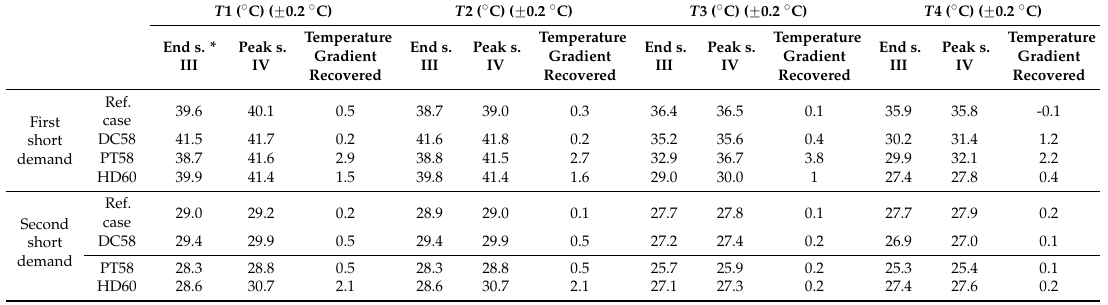
Table 8. Temperature gradients recovered after the two shorts demands for each temperature sensor.